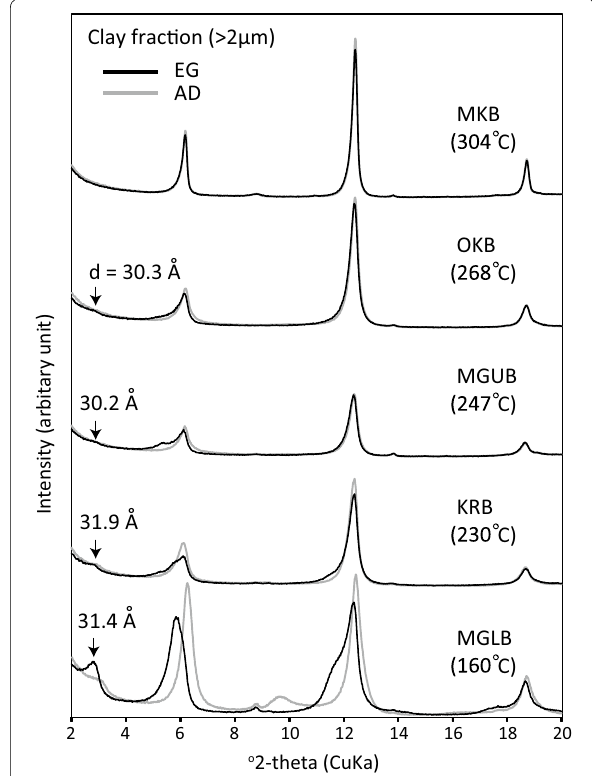
Fig. 5 XRD patterns for AD ( gray line ) and EG ( black line ) oriented mounts analyzed during this study. The peaks visible at ~31 Å cor- respond to the (001) reflection of